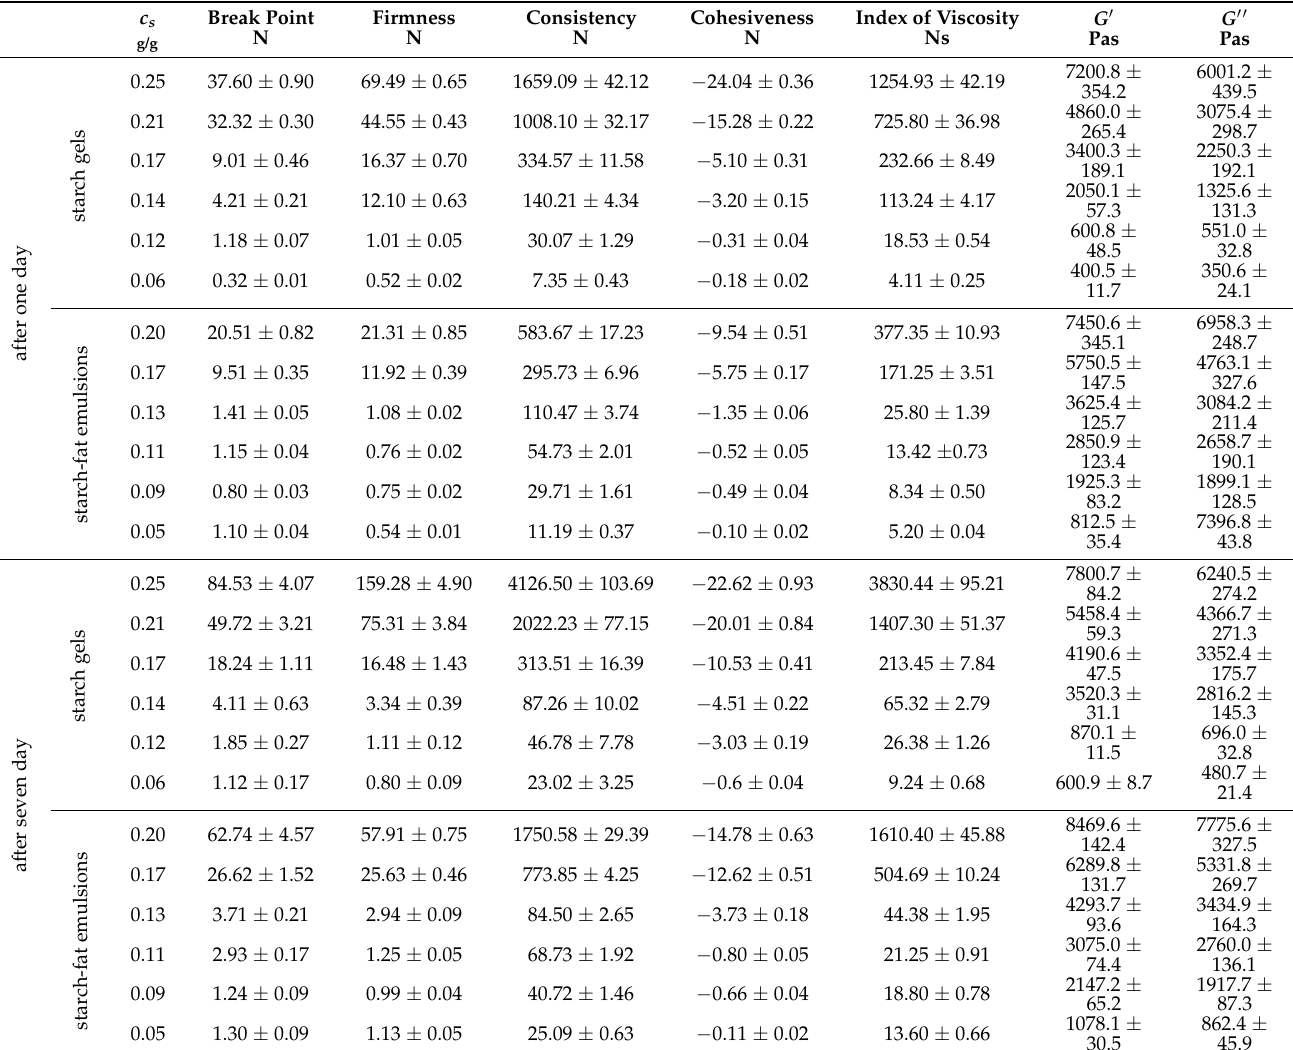
Table 3. The texture and rheomechanical parameters analysed of starch gels and starch–fat gels after one and seven days storage at temperature 25 ◦ C. The below values are expressed as means ± SD ( n =